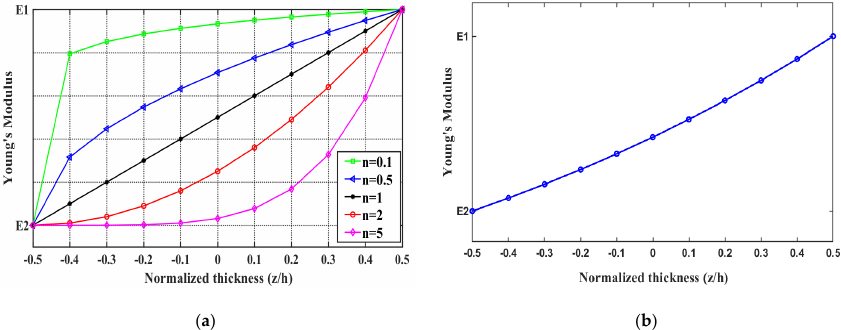
Figure 1. Variation of Young’s modulus in ( a ) P-FGM and ( b ) E-FGM.